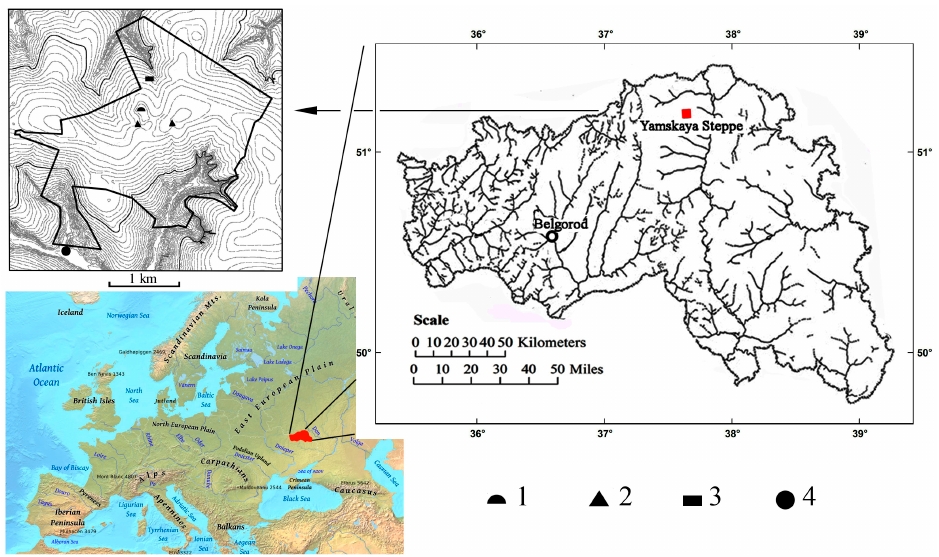
Figure 1. Locations of the study area and study objects: 1—Burial mound of the Bronze Age; 2—Closed depressions within the watershed plateau; 3—Marmot mound; 4—Colluvial fan and immature paleosols at the base of the “Vishnyaki” gully.